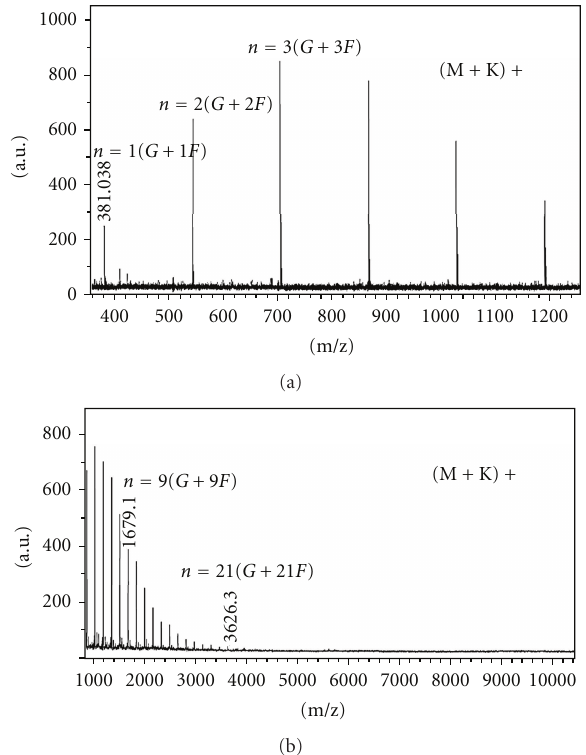
Figure 1: MALDI-TOF-MS spectra, in positive-ion mode of Agave salmiana fructan. (a) Low-mass spectra (DP from 1 to 6), (b) high- mass spectra (DP from 4 to 21).